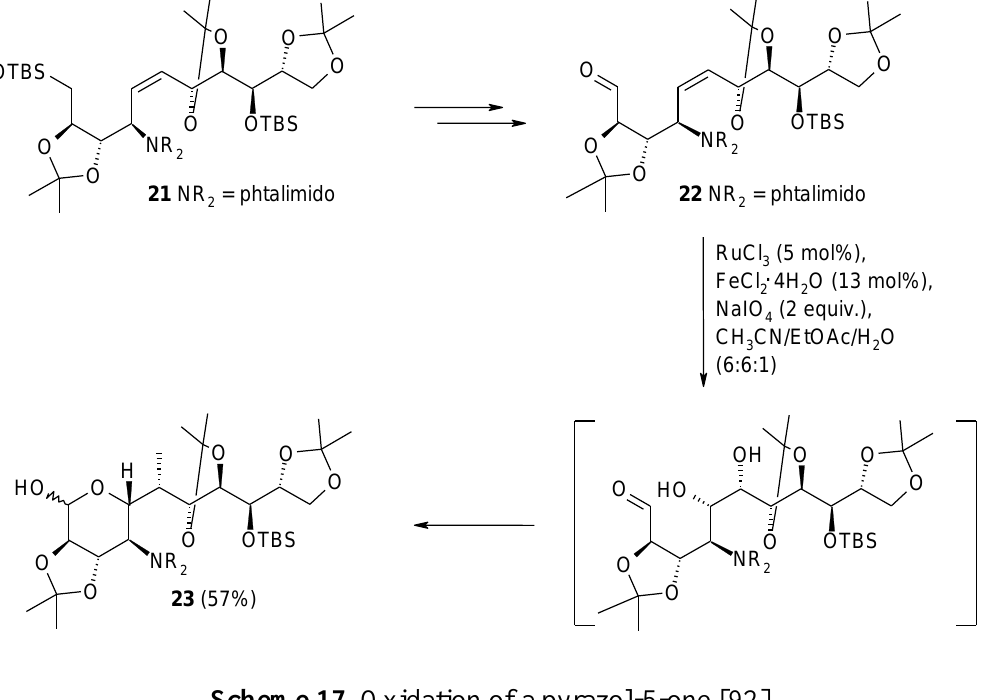
Scheme 17. Oxidation of a pyrazol-5-one [92].